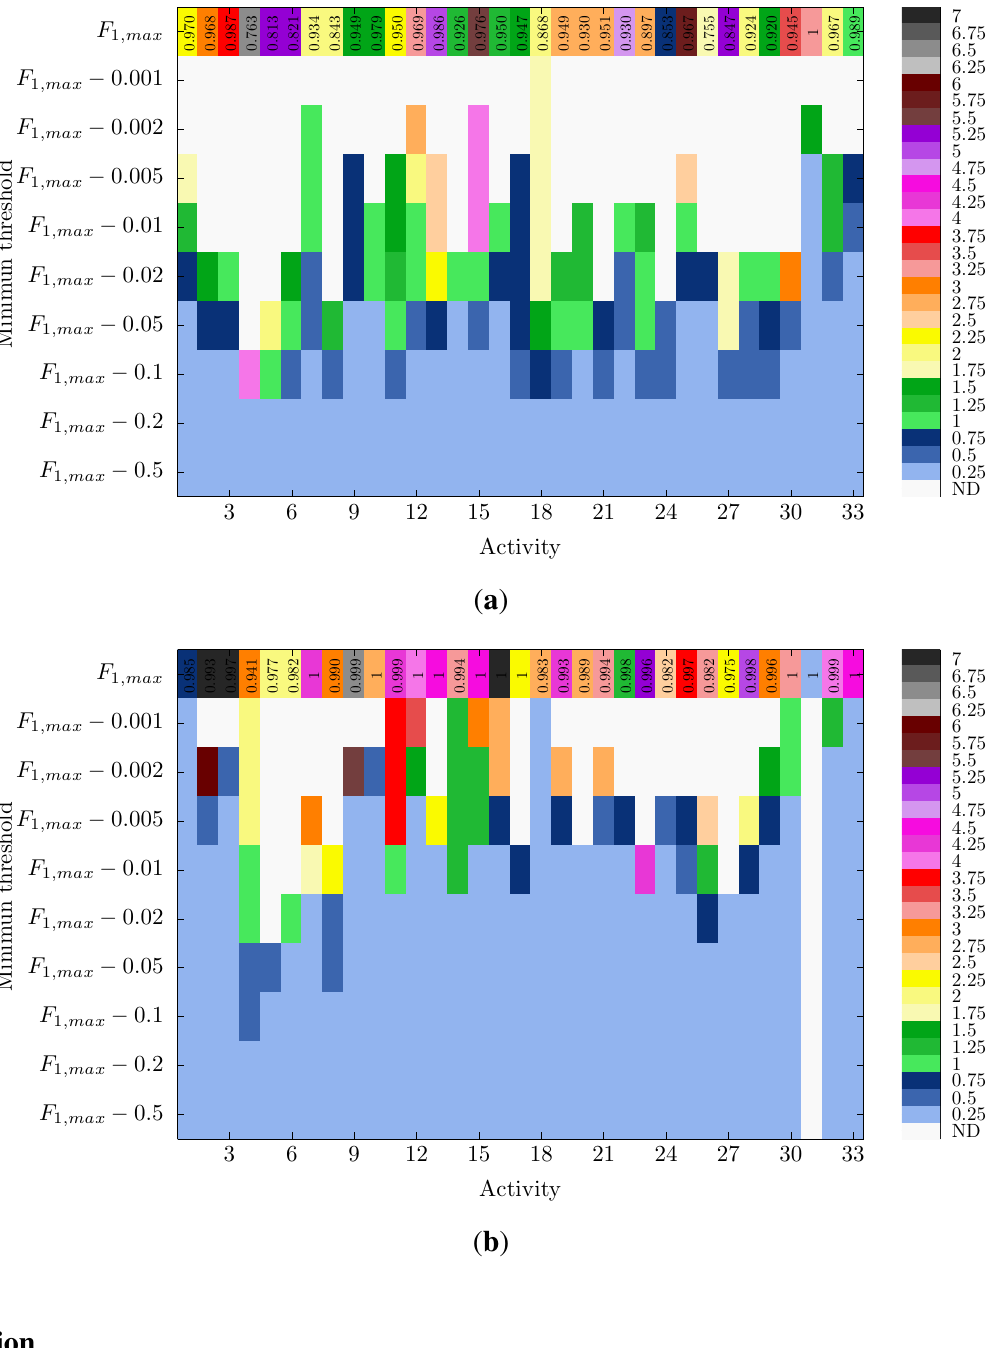
Figure 6. Minimum window size required for diverse performance thresholds. The threshold values are respectively calculated from the maximum F for the recognition of each activity (represented on top). The results for two particular recognition methodologies are shown: ( a ) DT-FS2; and ( b ) KNN-FS2. Non-colored spots (not defined, ND) correspond to performance values for which no window enhancement may be